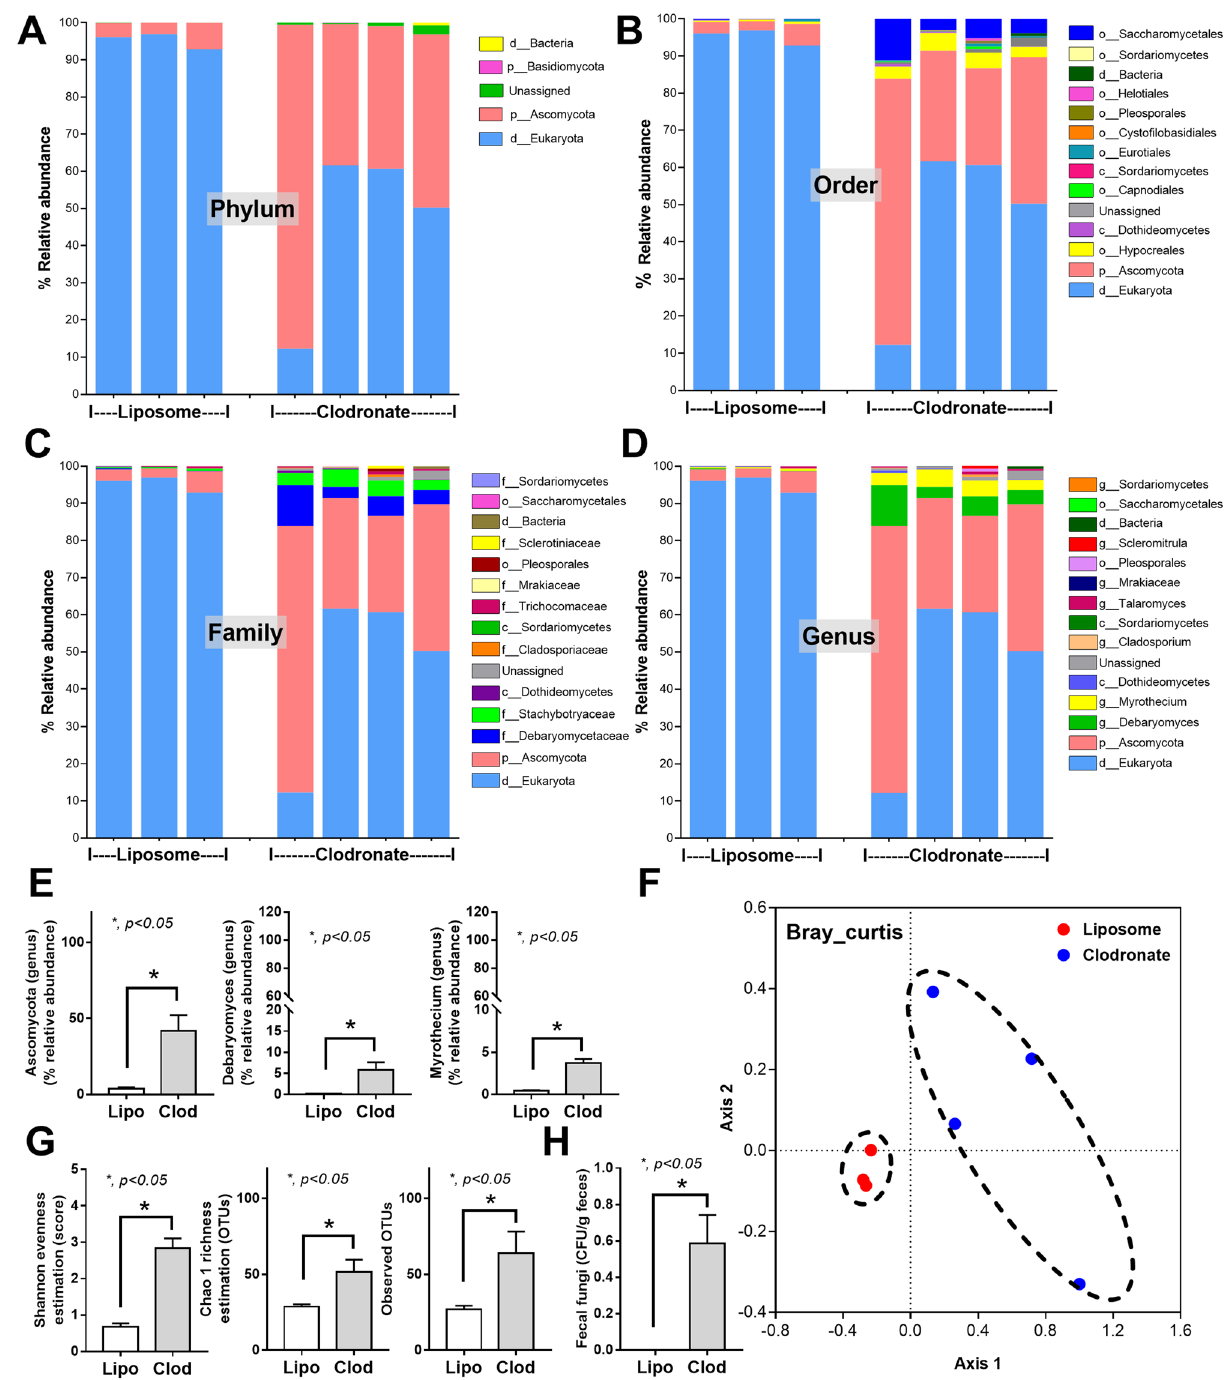
Figure 2. Fecal fungal microbiome (mycobiome) analysis from feces of mice with liposomal clodronate (Clod) or liposome control (Lipo) as indicated by the relative abundance in phylum, order, family and genus ( A – D ), graph demonstration of abundance of some genus ( E ), beta diversity (Bray Curtis) ( F ), alpha diversity (Shannon, Chao and observed total OTUs) ( G ) are demonstrated. Additionally, fecal fungal abundance by culture method ( H ) are also